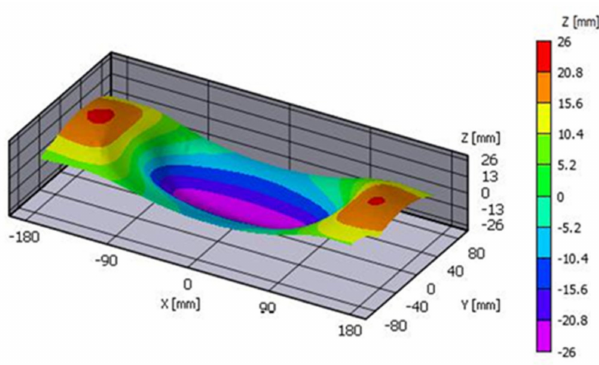
Figure 6. 3D reconstruction using DIC analysis for Specimen #20 (buried).